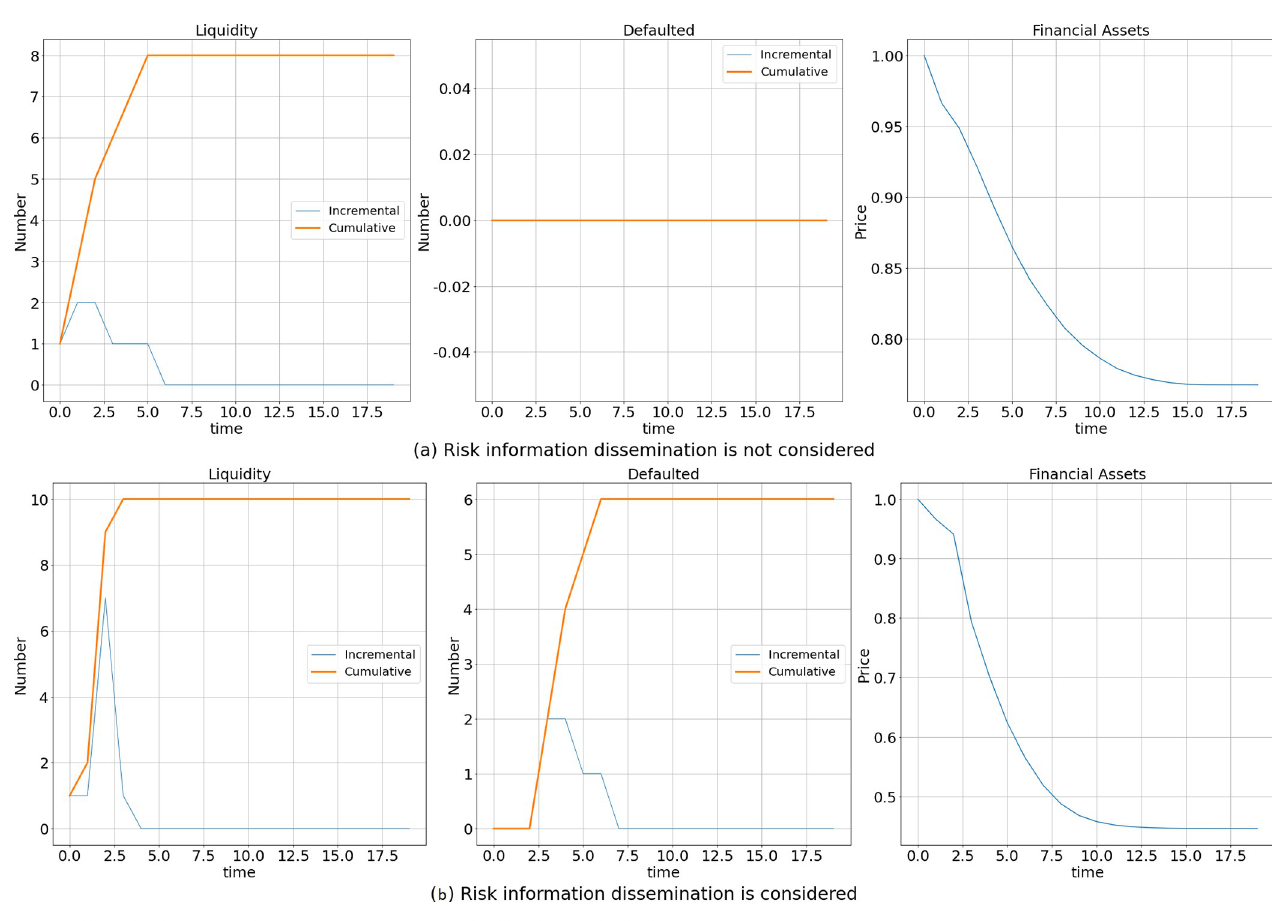
Fig 3. Effect of information dissemination when individual banks are shocked one by